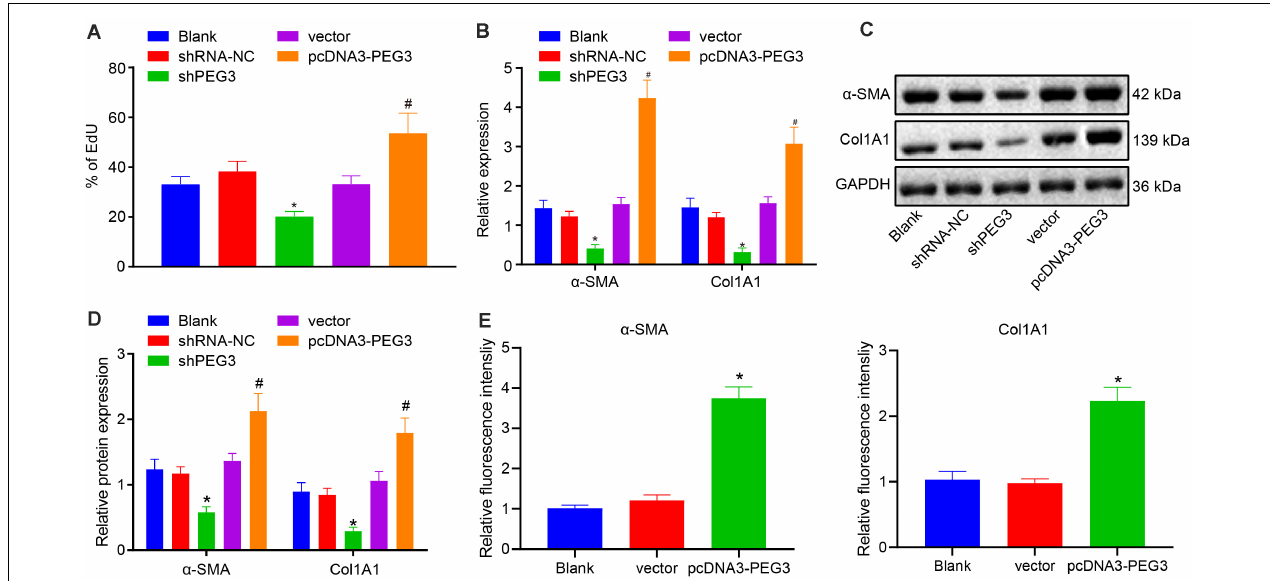
FIGURE 4 | Depletion of PEG3 inactivates HSCs in vitro . (A) HSC proliferation after transfection detected by EdU assay. (B) Relative mRNA levels of α -SMA and Col1A1 in HSCs after transfection determined by RT-qPCR. (C) Protein bands of α -SMA, Col1A1, and GAPDH in HSCs after transfection. (D) Relative protein levels of α -SMA and Col1A1 normalized to GAPDH in HSCs after transfection determined by western blot analysis. (E) Quantitative analysis on α -SMA and Col1A1 immunofluorescence intensity in primary HSCs. * p < 0.05 vs. the blank group (HSCs without transfection). # p < 0.05 vs. the vector group (HSCs treated with vector). All data were measurement data and expressed as mean ± standard deviation. One-way analysis of variance was used for data comparison among multiple groups. The experiment was independently repeated three times. N = 6. α -SMA, α -smooth muscle actin; Col1A1, collagen type I alpha 1; RT-qPCR, reverse transcription quantitative polymerase chain reaction; GAPDH, glyceraldehyde-3-phosphate dehydrogenase.